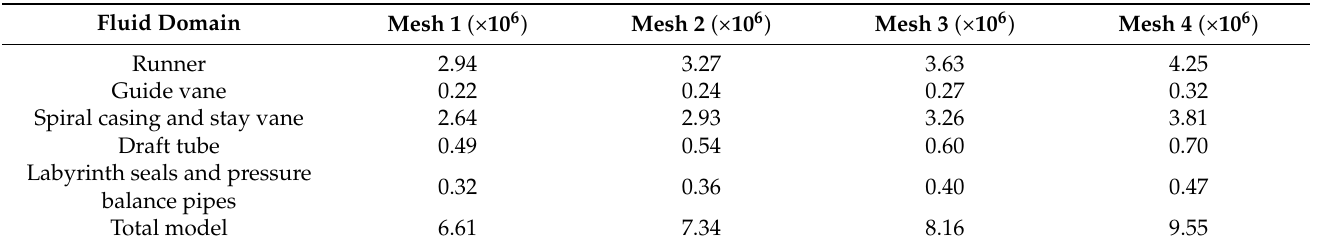
Table 1. Number of elements of the four sets of